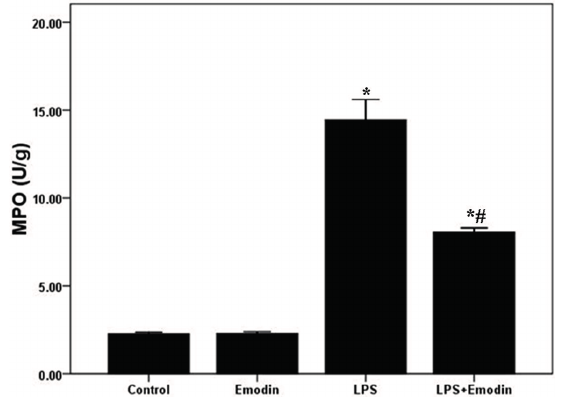
Figure 3. Emodin inhibits myeloperoxidase (MPO) activity in LPS-induced ALI. After 72 h interventions, mice were sacrificed, and their lungs were removed. MPO activity was measured to assess the accumulation and activation of neutrophils in the lung tissues. Each bar represents the mean ± SD of 10 mice. * p < 0.05 compared with Control. # p < 0.05 compared with LPS.